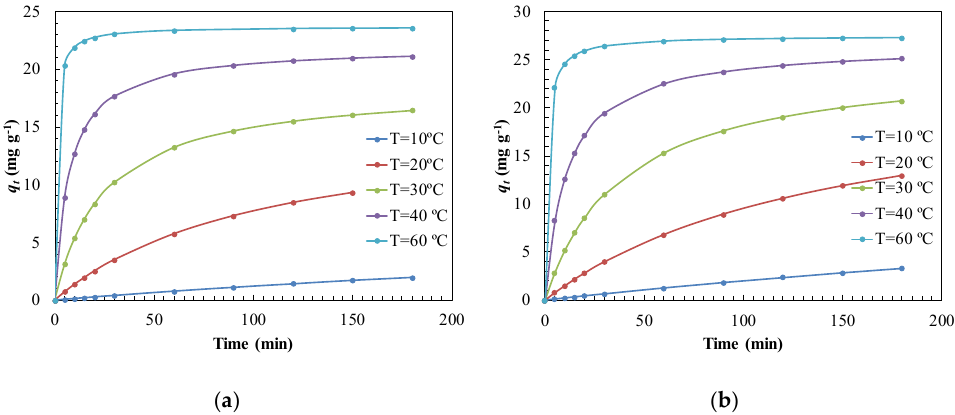
Figure 5. Evolution of the adsorbed capacity with time for effect of temperature ( a ) aniline at pH = 12.0 and ( b ) benzothiazole at pH = 8.0 on TiO 2 P25 catalyst.